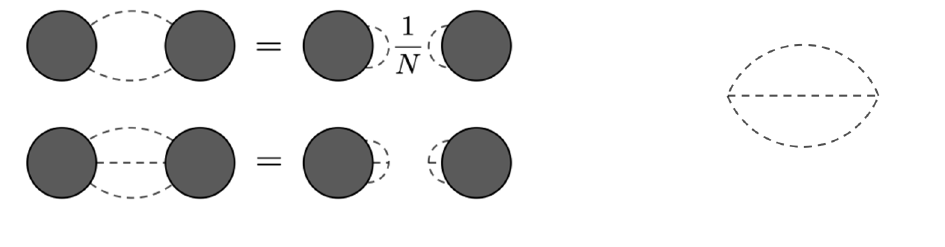
Figure 2 . Left: factorization properties of 2PR (top) and 3PR (bottom) representations of isospin diagrams. Right: the melon diagram, i.e. the simplest 2-particle irreducible isospin